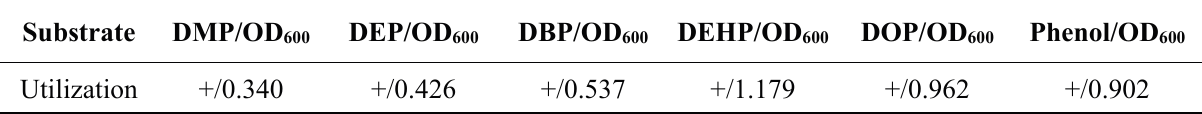
Table 1. Substrate utilization profile of strain